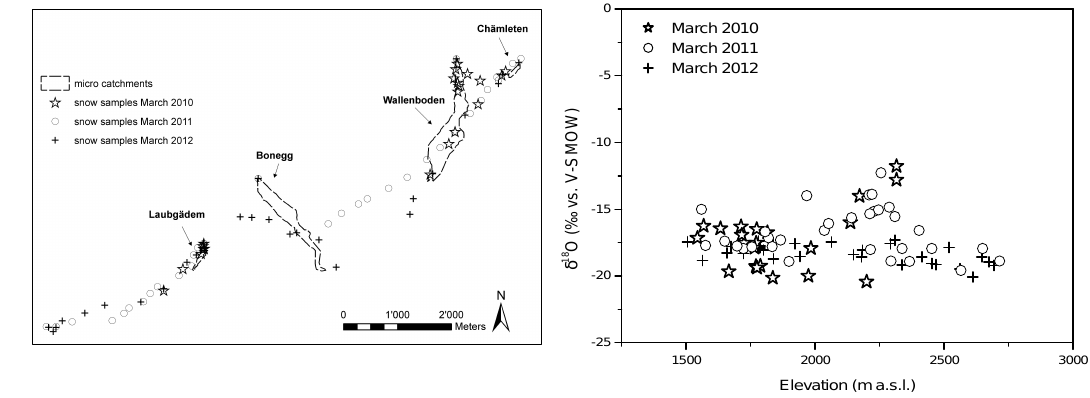
Fig. 2. Location of snow sampling at the end of the winter (left) and stable isotopes values of snow (right). Table 3. Mean water transit times (MTT) and hydrogeological parameters of the micro catchments (means ± standard deviations calculated for parameter sets C to E). Ch¨amleten Wallenboden Bonegg Laubg¨adem